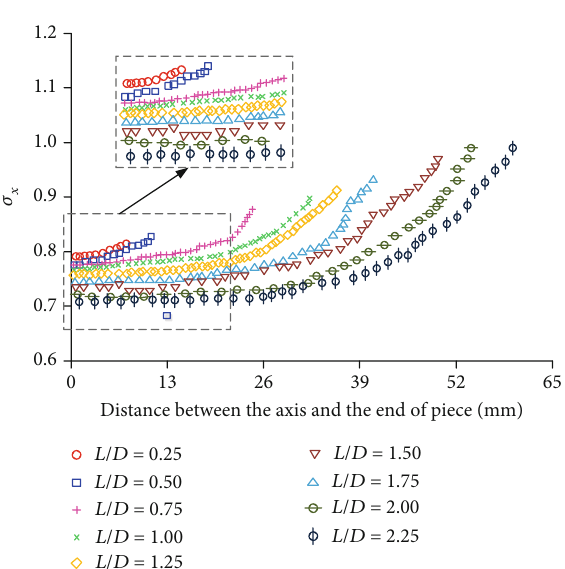
Figure 4: Tensile stress distribution on the central axis of di ff erent height to diameter ratio samples.